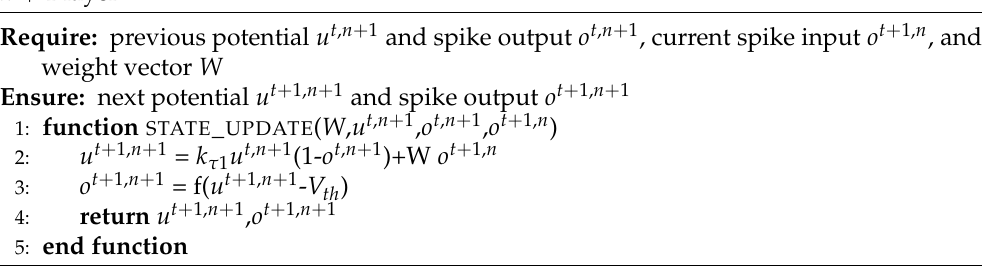
Algorithm 1 State update for an explicitly iterative LIF neuron at time step t + 1 in the n + 1